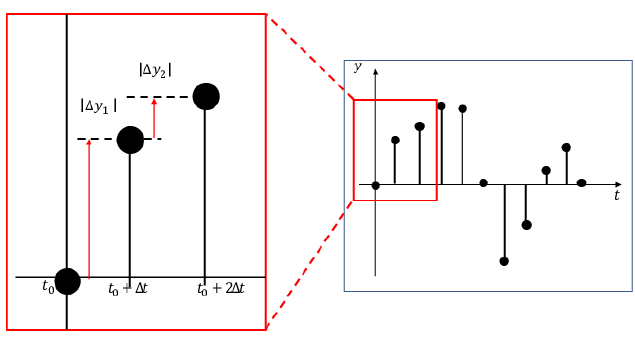
Figure 11. Calculation of signal